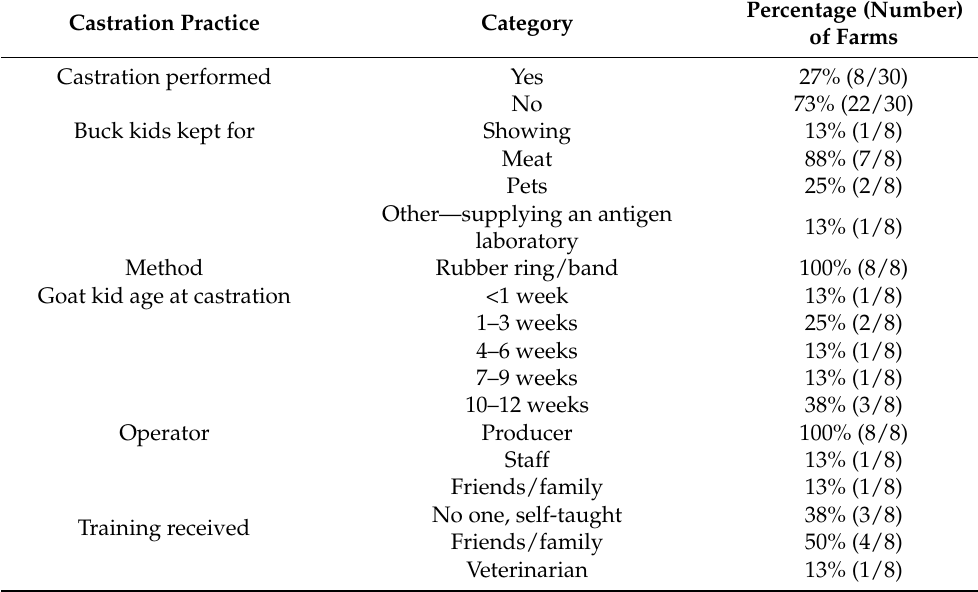
Table 8. Dairy goat producer responses relating to castration